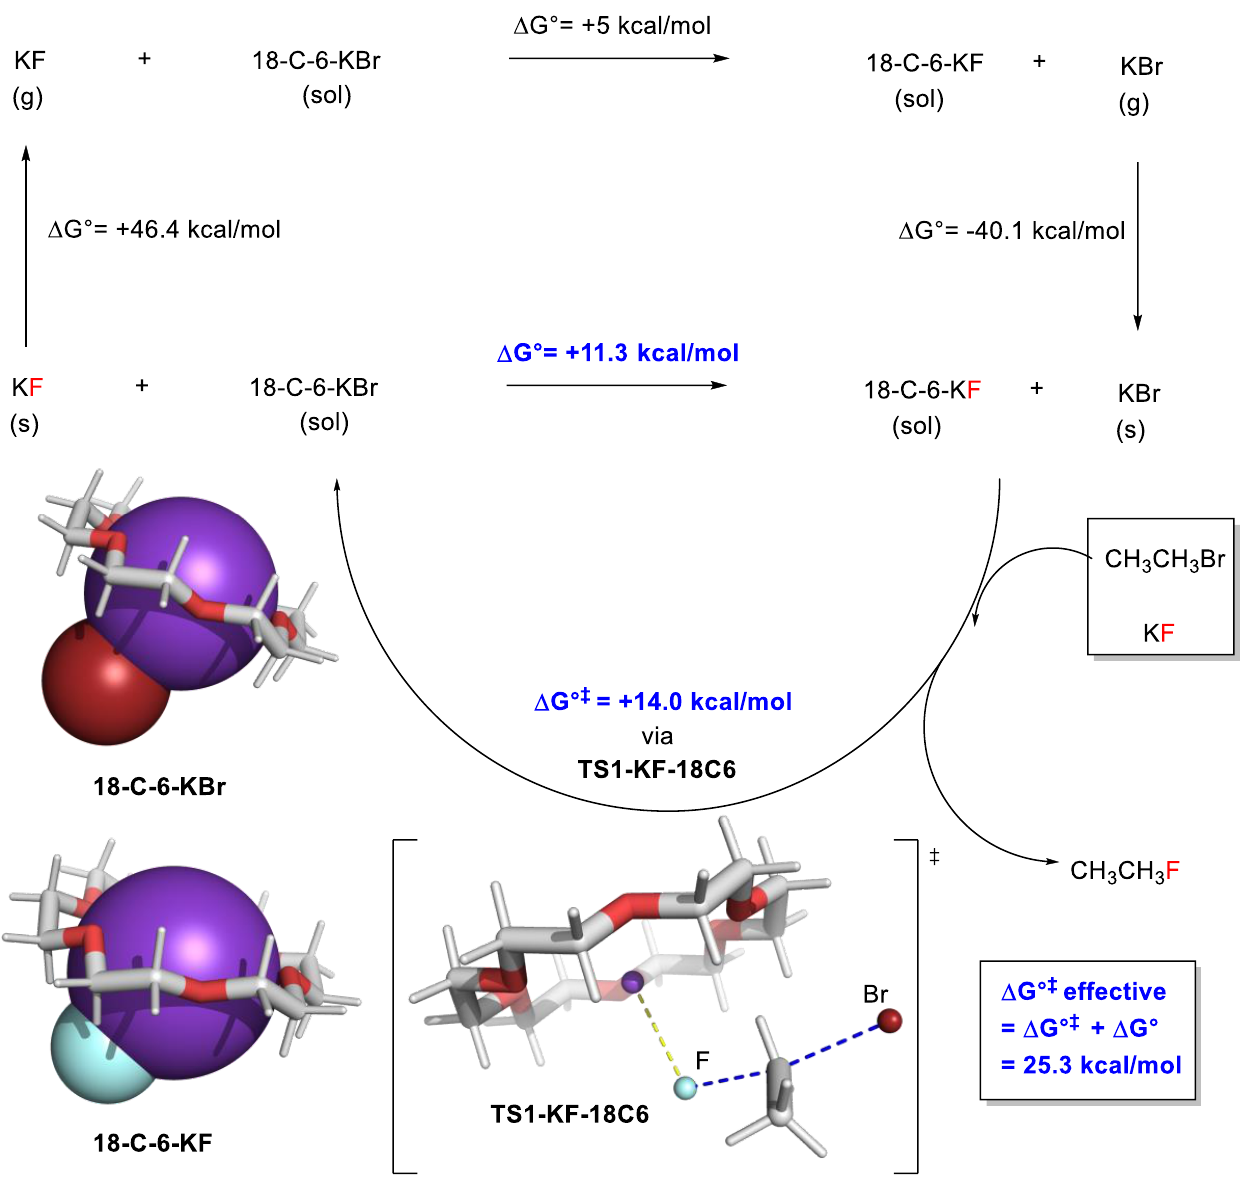
Figure 8. Use of thermodynamic cycle in 18-crown-6-catalyzed fluorination of alkyl bromide. All values are obtained from the work of Pliego Jr and Riveros in ref [109]. Fluoride is colored red to facilitate identification. (sol) refers to solution. (s) refers to solid.